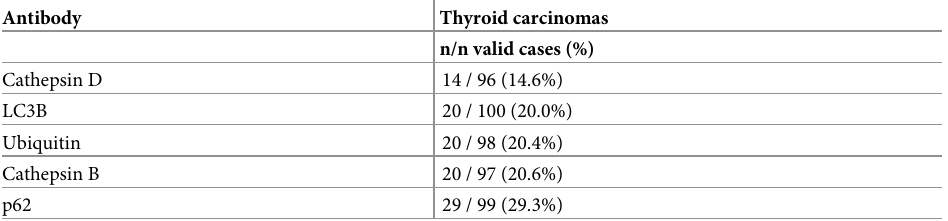
Table 3. Immunostaining of autophagy-related proteins in the intranuclear inclusions of the complete TC cohort.